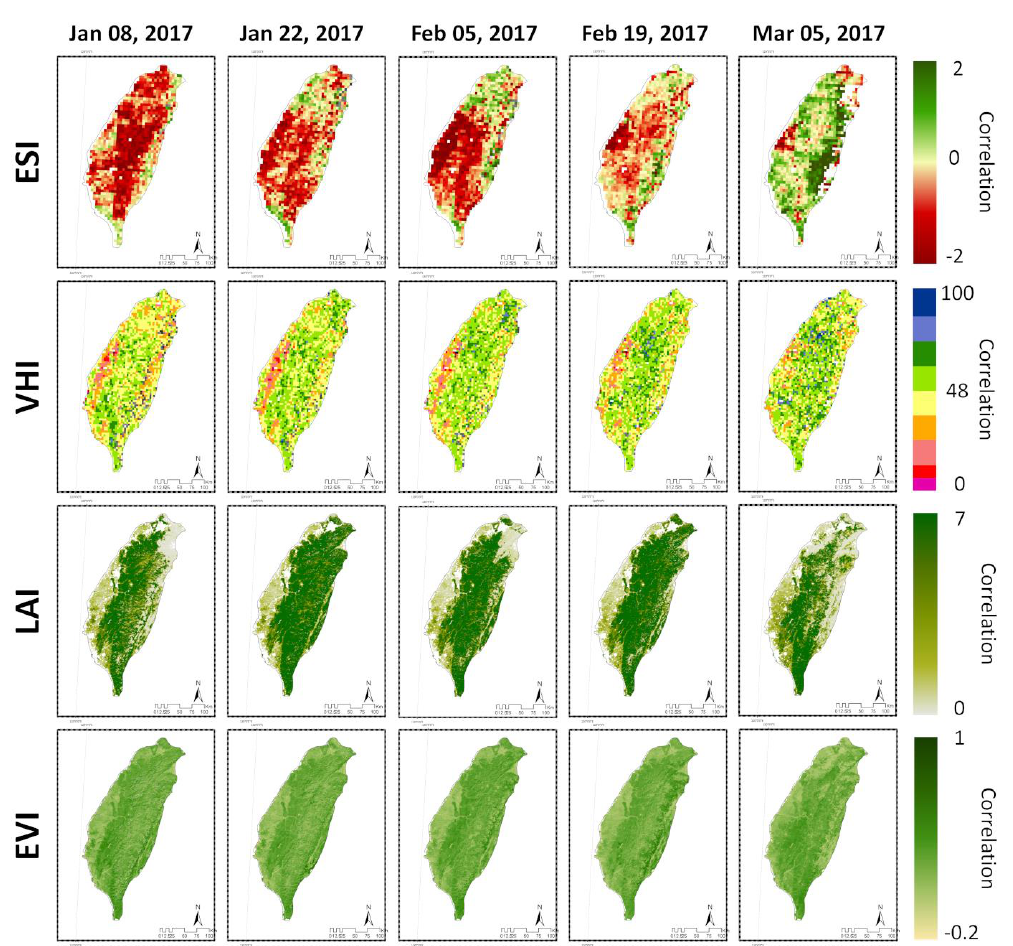
Figure 2. Comparison of trends for each drought index for Taiwan.